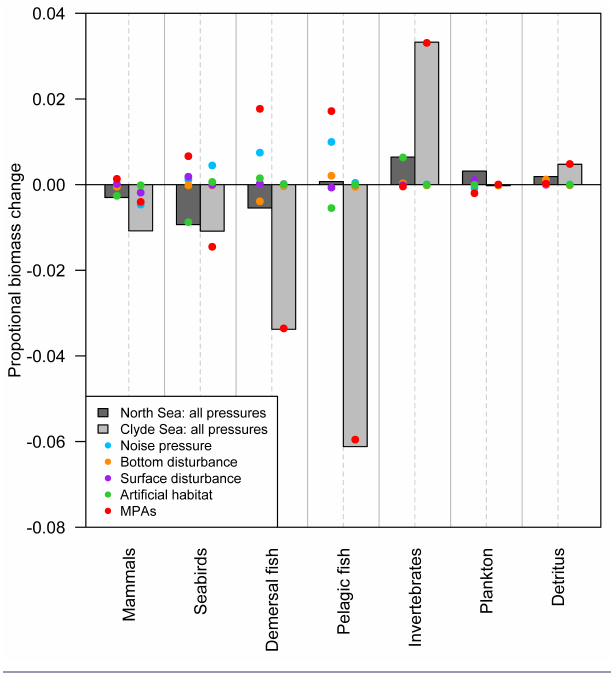
Fig. 10. Comparison of proportional changes in the biomass of ecological groups in the North Sea and Firth of Clyde marine spatial planning (MSP)-Ecopath with Ecosim models after the implementation of MSP start-up pressure layers. The baseline (0) denotes the biomass prior to the addition of these pressures. MPAs = marine protected